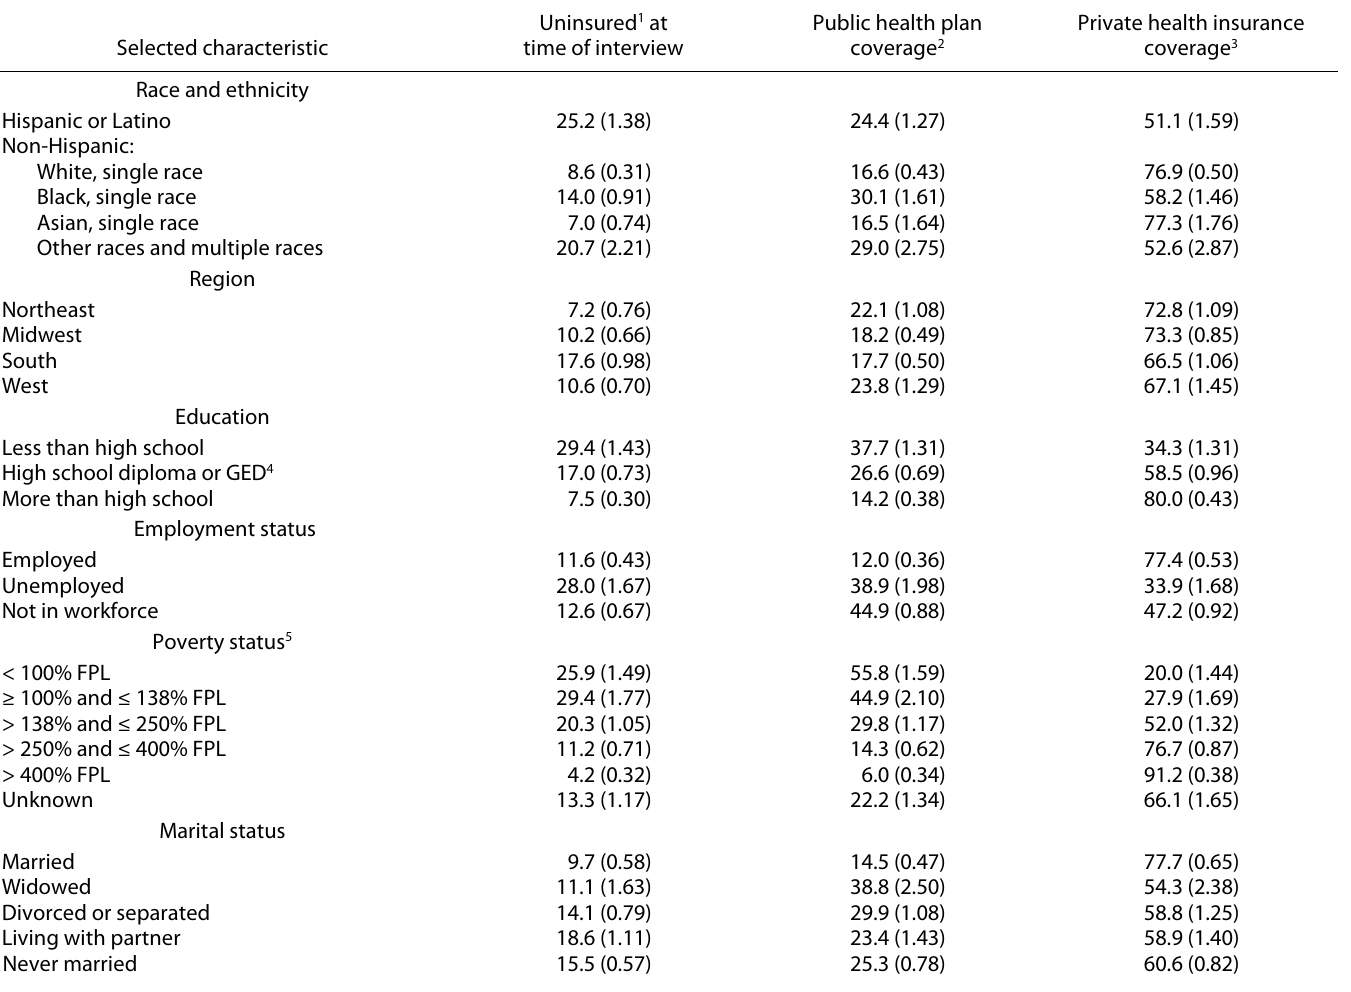
Table X. Percentages (and standard errors) of adults aged 18–64 who lacked health insurance coverage, had public health plan coverage, and had private health insurance coverage at the time of interview, by selected demographic characteristics: